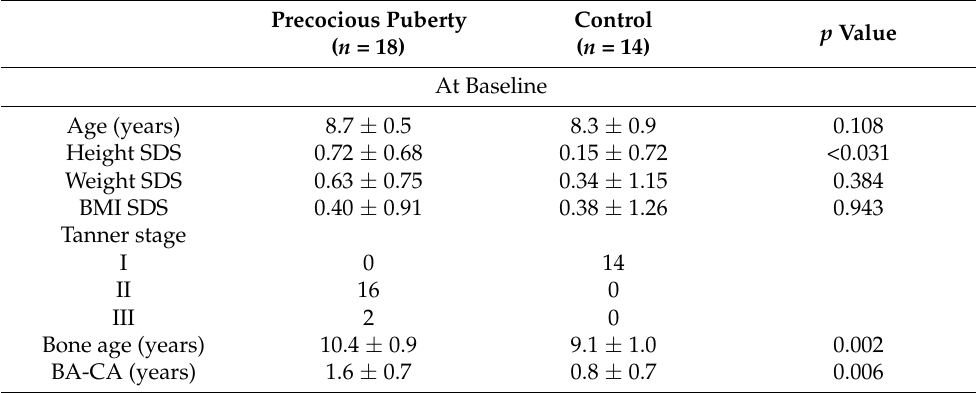
Table 1. Anthropometric measurements at baseline and after 1